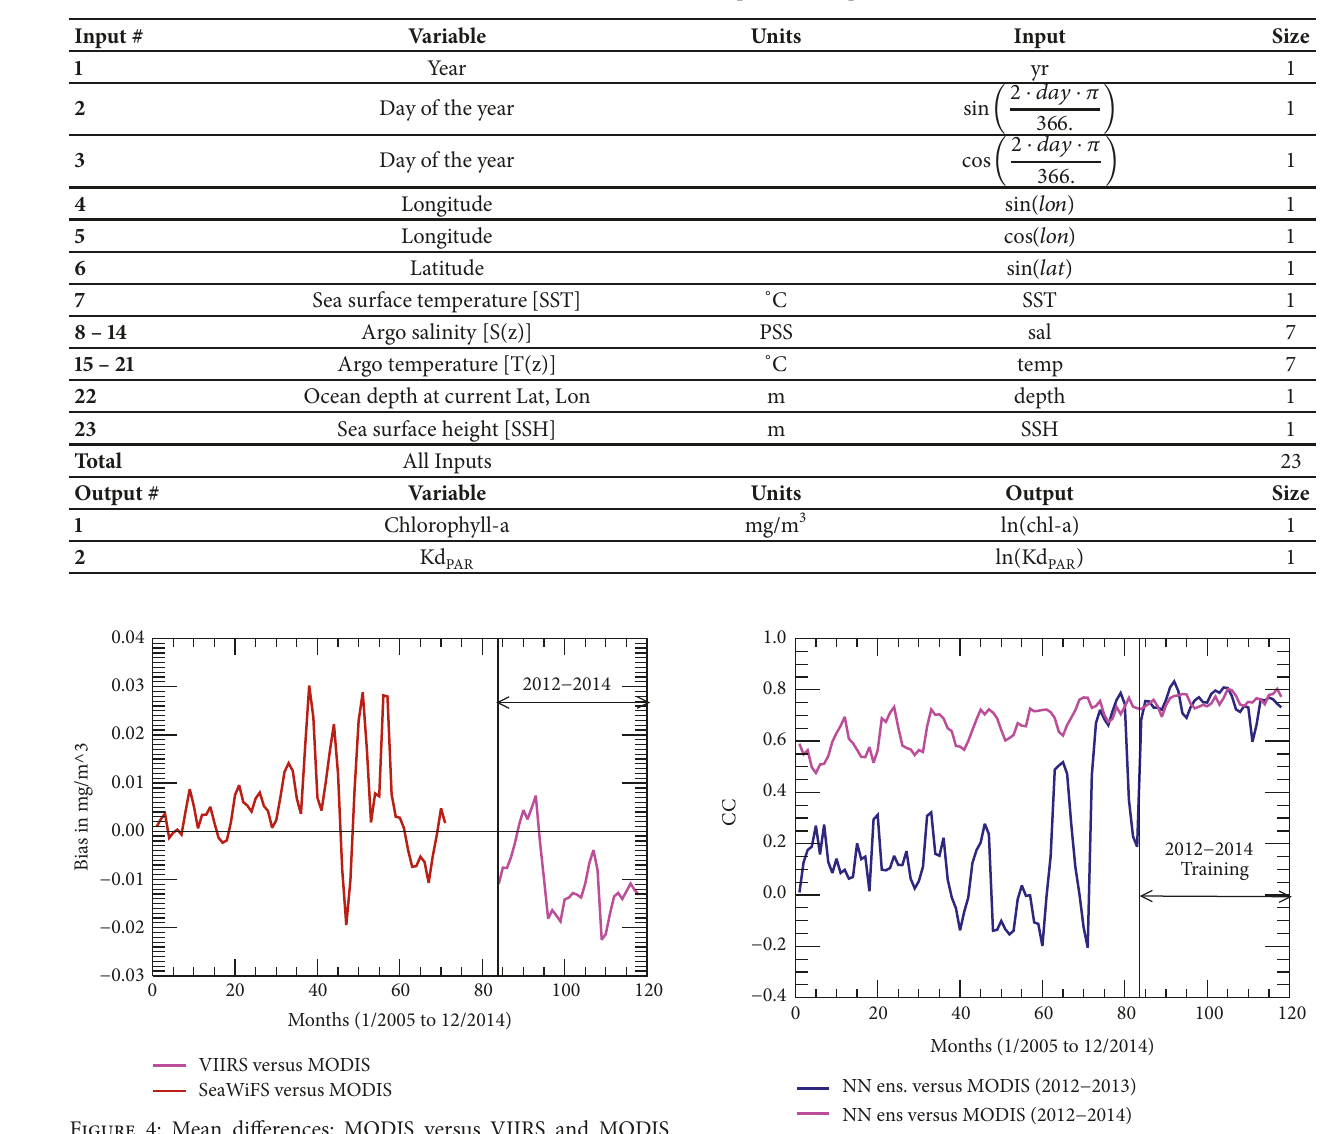
Table 1: Neural network inputs and outputs.